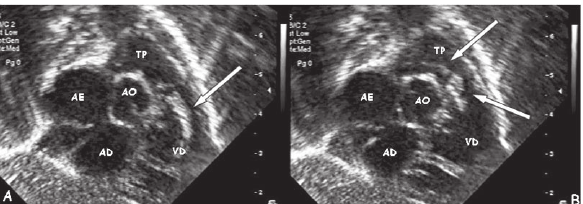
Fig. 1 – Cortes ecocardiográficos subcostal coronal